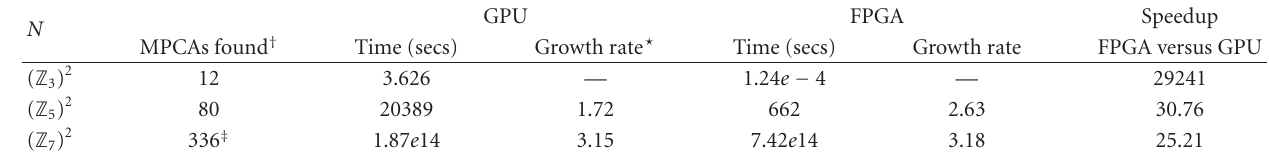
Figure 7: Detail of the Costas evaluation block. Table 1: Experimental results for MPCA enumerations.